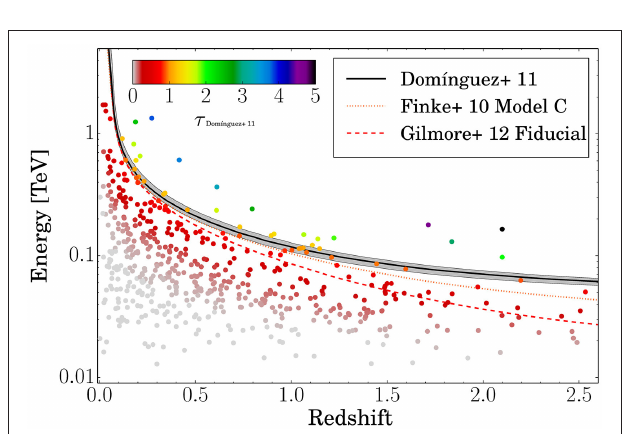
FIGURE 2 | The highest-energy photons vs. redshift for 3FHL blazars, color coded by the optical depth calculated from the model presented by Dominguez et al. (2011). The cosmic γ -ray horizon based on different EBL models is shown. Adapted from Ajello et al.